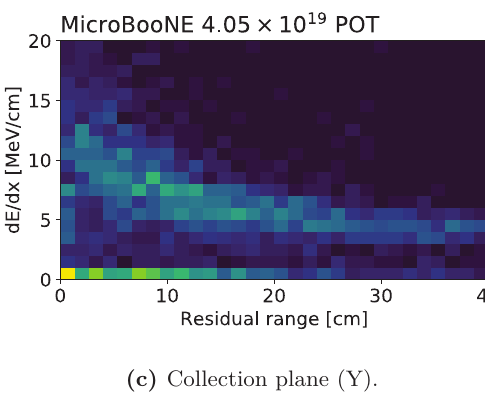
Figure 8. 2D distribution of d E/ d x and residual range measured on the three wire planes for tracks identified as proton candidates in the data, with large collection plane local